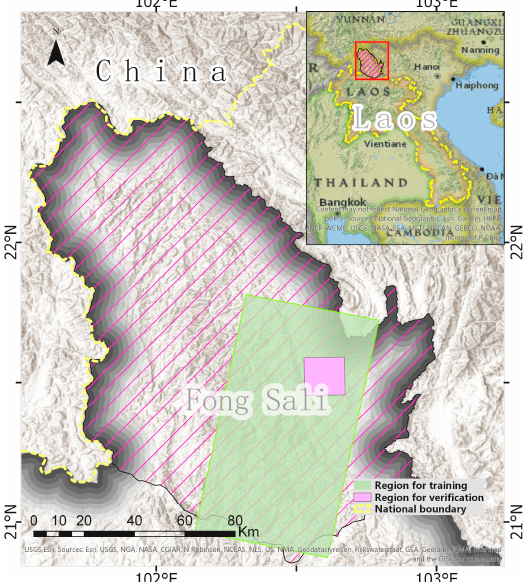
Figure 3. Location of the study area. The region marked by pink lines is Phongsali province; the pink rectangle represents the area used for verification, and the green polygon represents the area used for training.